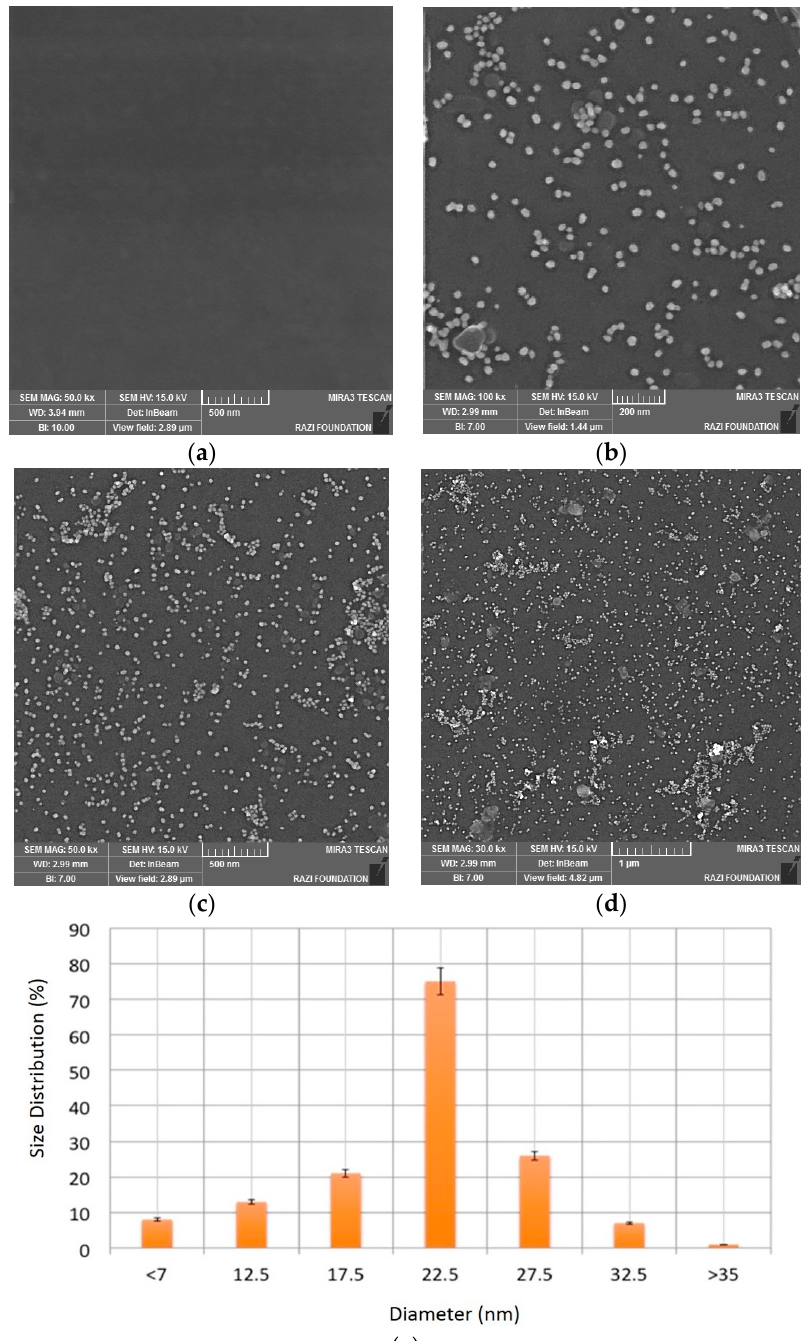
Figure 3. GNPs characterization results using FE-SEM: ( a ) Bare ITO and GNPs-coated ITO with ( b ) 200 nm; ( c ) 500 nm and ( d ) 1000 nm scale bars; and ( e ) an image processing software-Image J. All analyses were repeated for three times.